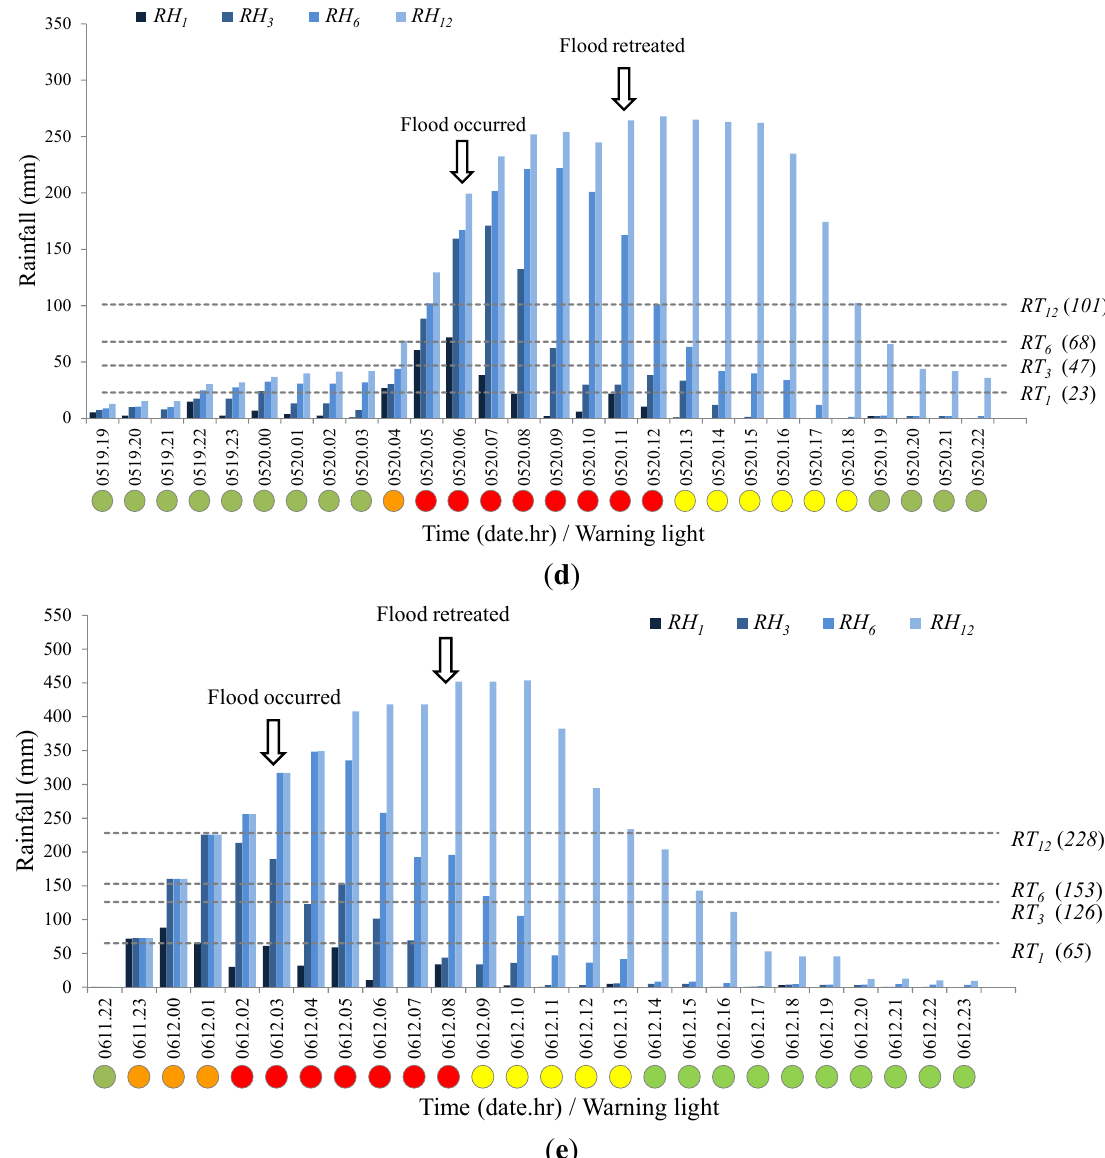
Figure 10. Warning time series for ( a ) Typhoon Morakot at Puzi Township; ( b ) Typhoon Fanipi at Meinong Township; ( c ) Typhoon Megi at Suao Township; ( d ) Rainstorm 0520 at Rende Township; ( e ) Rainstorm 0610 at Jongli Township ( and denotes rainfall threshold with i h of i RT